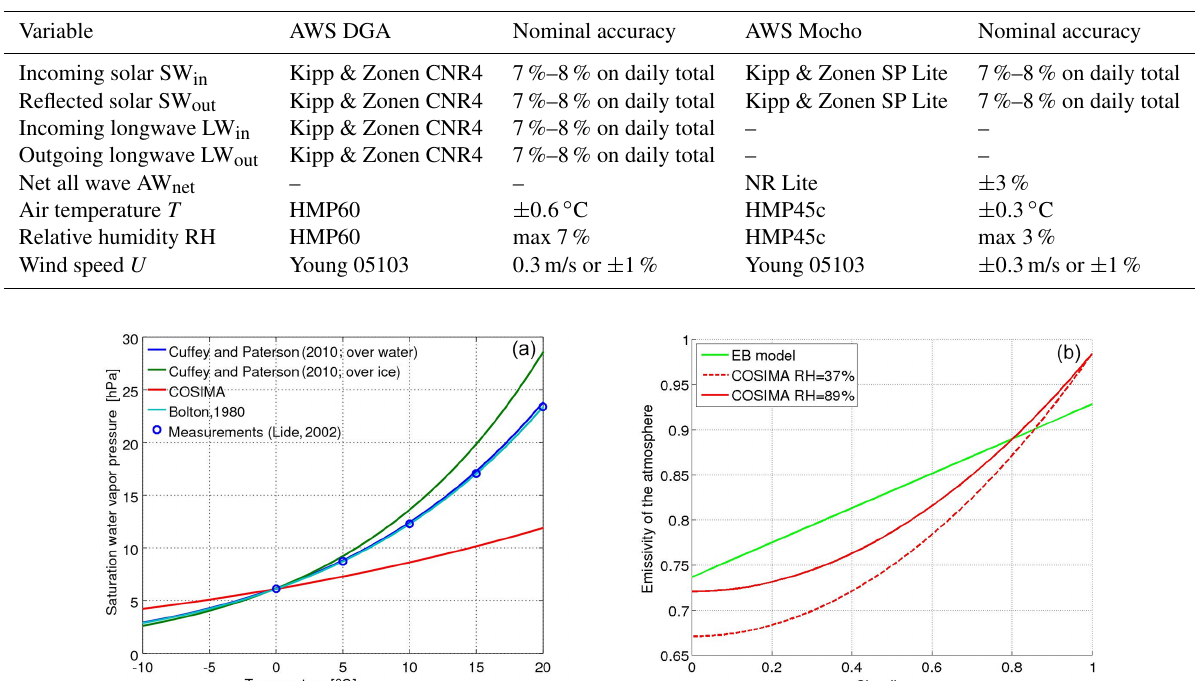
Table 2. Sensors employed at the different AWSs.